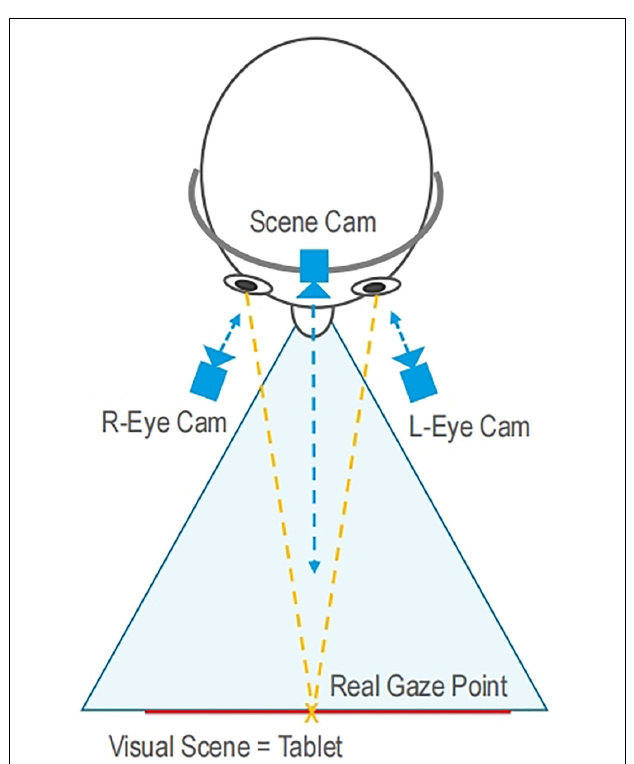
FIGURE 3 | Schematic of eye movement